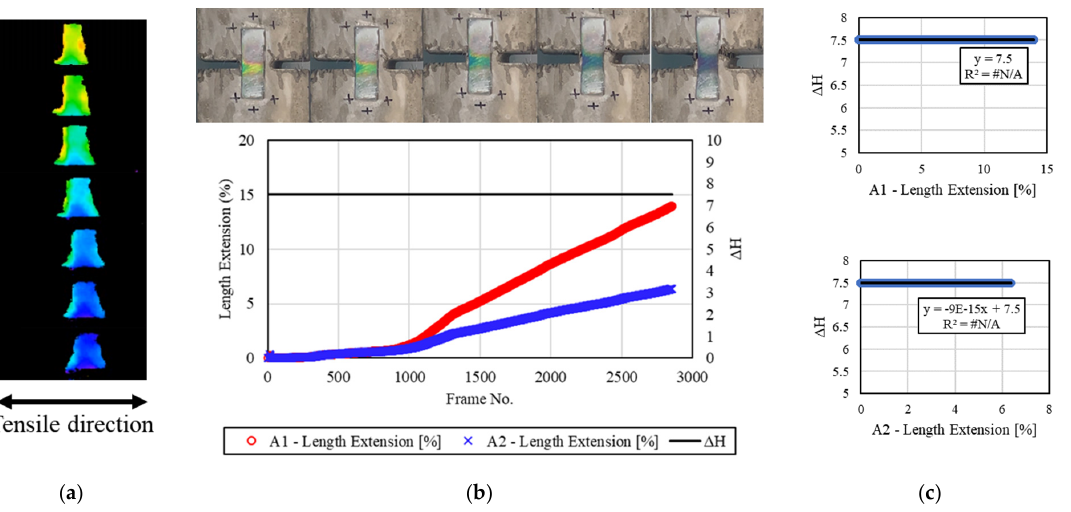
Figure 7. Results for the specimens after 1.0 h. ( a ) H-value image for discoloration color of mechanochromic sensor (90° rotation relative to tensile direction); ( b ) variations in strain and dH of A1 and A2 according to image frame. (The discoloration process of the mechanochromic sensor attached to the specimen and the tensile strain described in Figure 3 are shown.); ( c ) correlations of dH with A1 and A2.